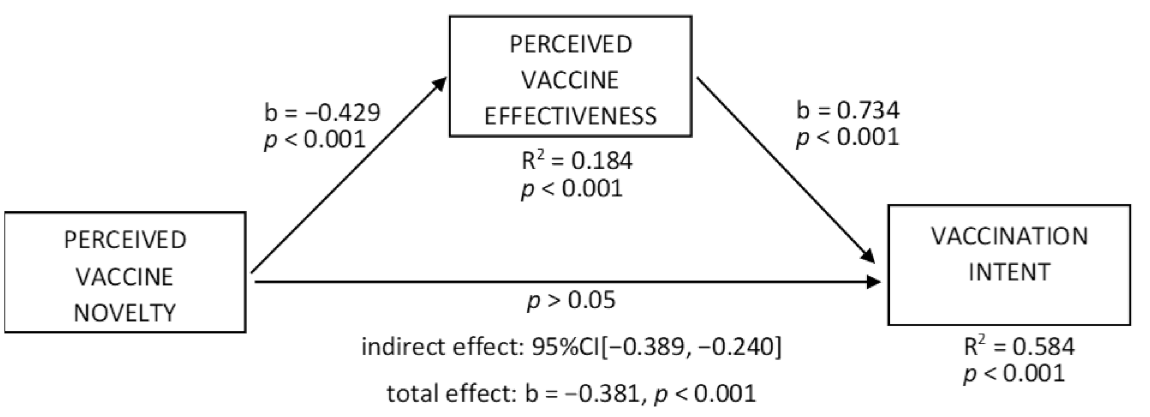
Figure 5. Mediation effect of perceived vaccine effectiveness—vaccination intent as a dependent